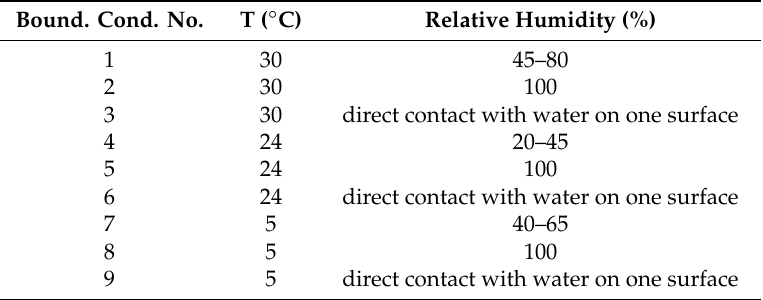
Table 4. Boundary conditions in the second phase.